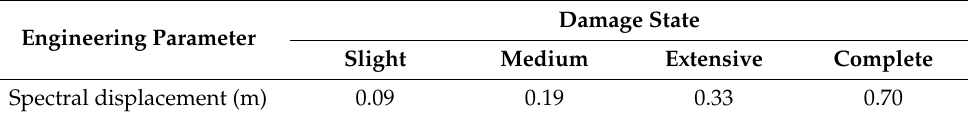
Table 5. Damage state for developing fragility